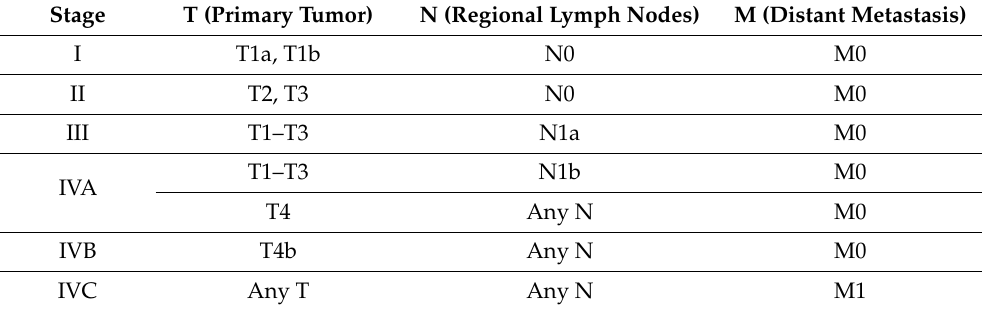
Table 2. MTC staging